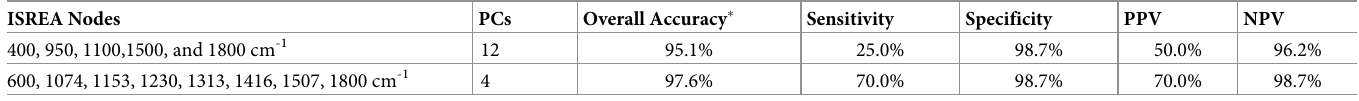
Table 5. Detection of long COVID-19 in urine by Rametrix 1 given two different ISREA node sets. ISREA